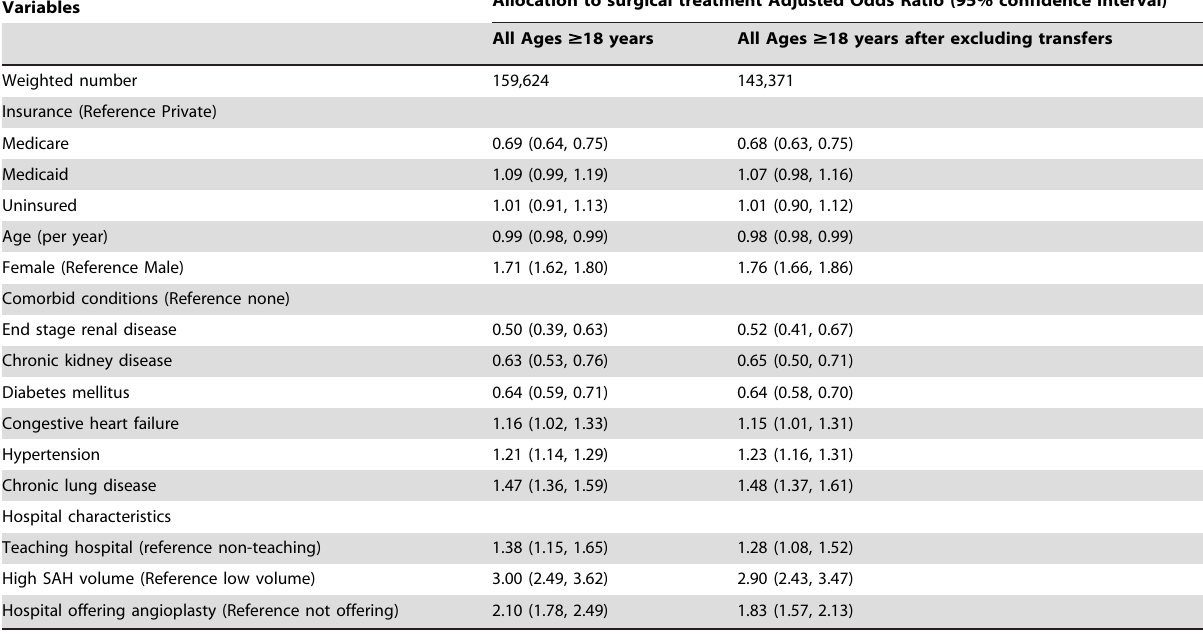
Table 2. Adjusted Odds of Allocation to Surgical Treatment for Subarachnoid Hemorrhage.